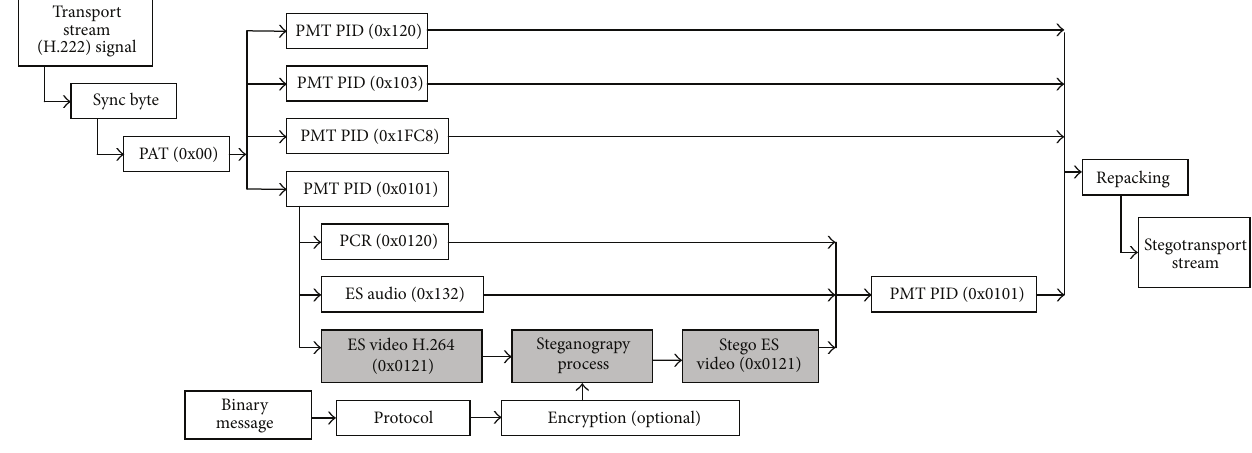
Figure 1: Overview of the scheme